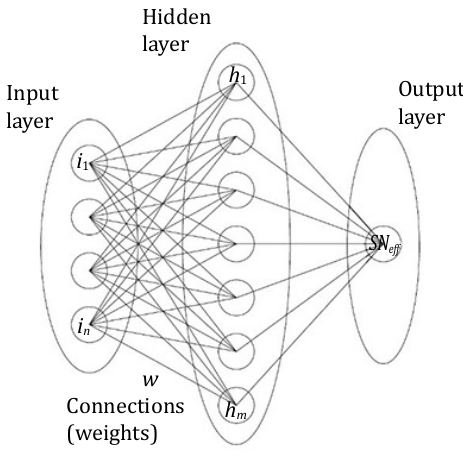
Figure 3. The general architecture of the Artificial Neural Network